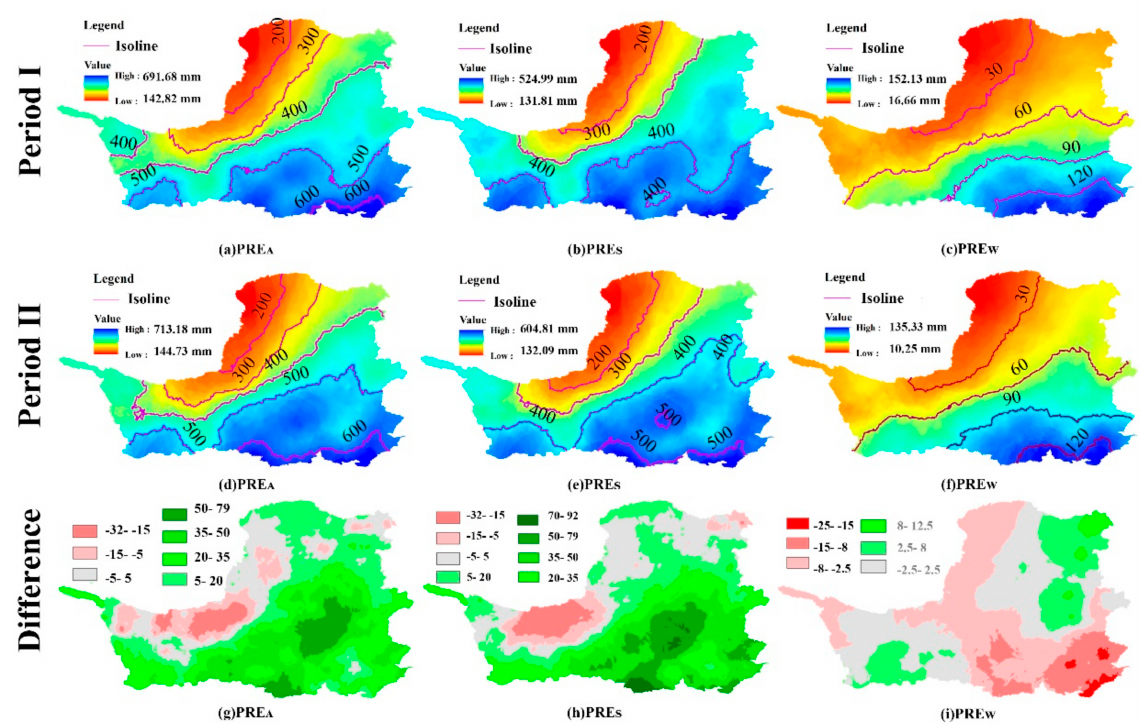
Figure 5. The spatial distribution of precipitation in Period I (( a ) annual precipitation PRE A , ( b ) summer precipitation PRE S , ( c ) winter precipitation PRE W ) and Period II ( d , e , f ) and the difference in precipitation between the two periods ( g , h , i